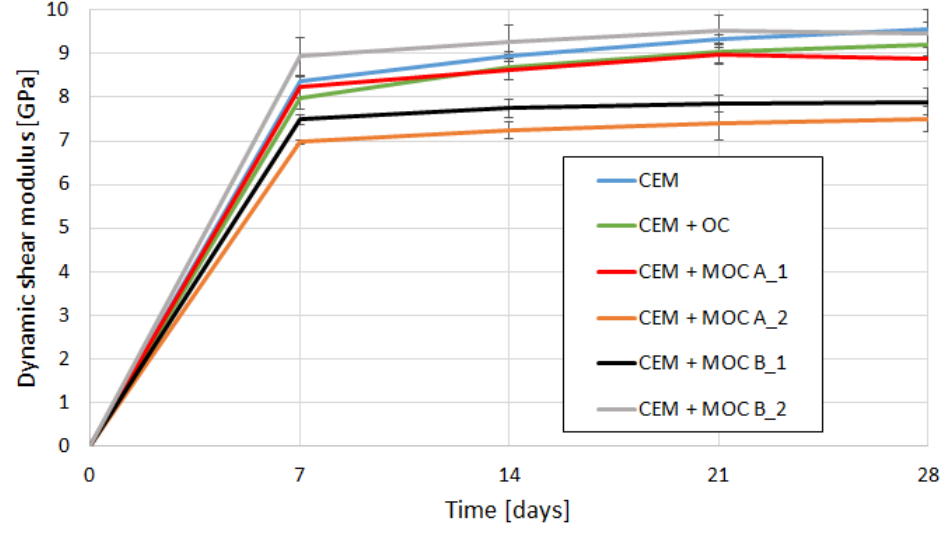
Figure 4. Development of dynamic shear modulus.